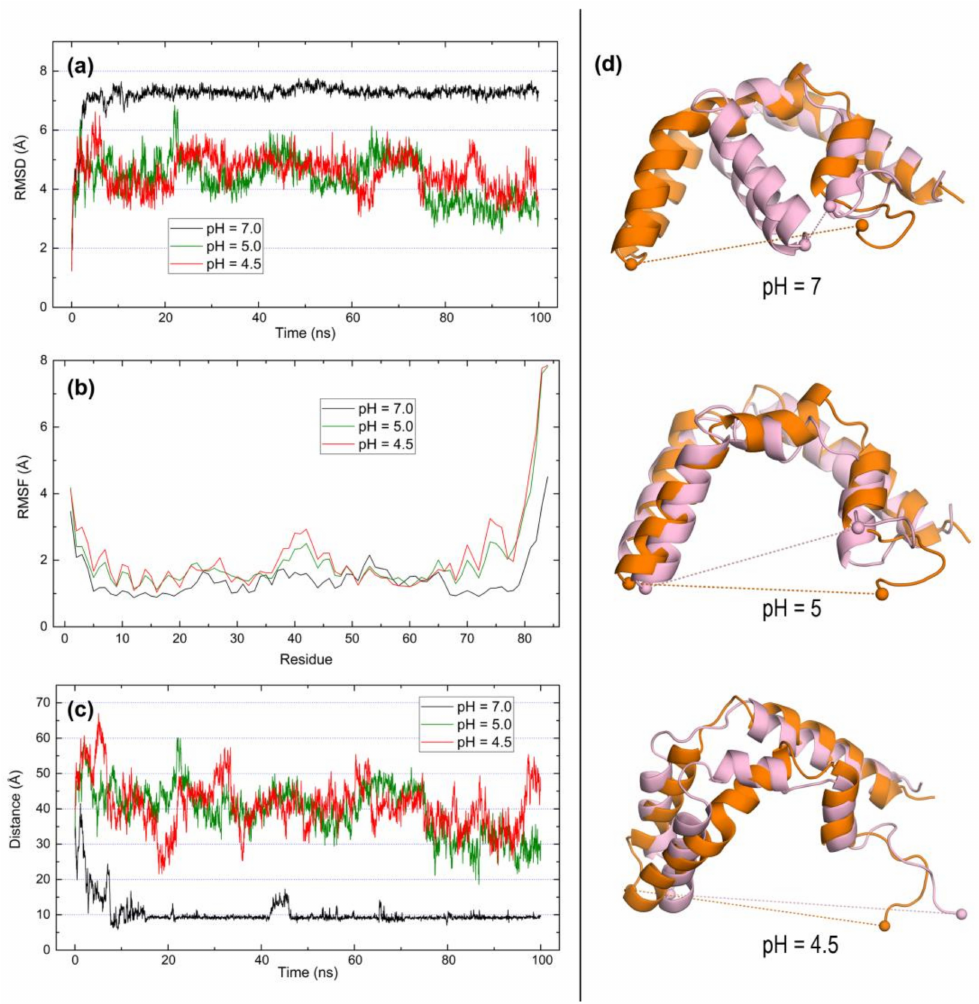
Figure 8. Results of 100-ns MD simulations on the open form of saposin C (chain 1 in 1SN6) at pH 7, 5, and 4.5. ( a ) RMSD of backbone atoms. ( b ) RMSF of all residues. ( c ) Distance between alpha carbons of P40 and R84 residues. ( d ) Structural superposition of initial (orange) and final (pink) structures in the simulations computed with TM-Align [42]. Dashed lines indicate distances between C α atoms of P40 and R84 represented as